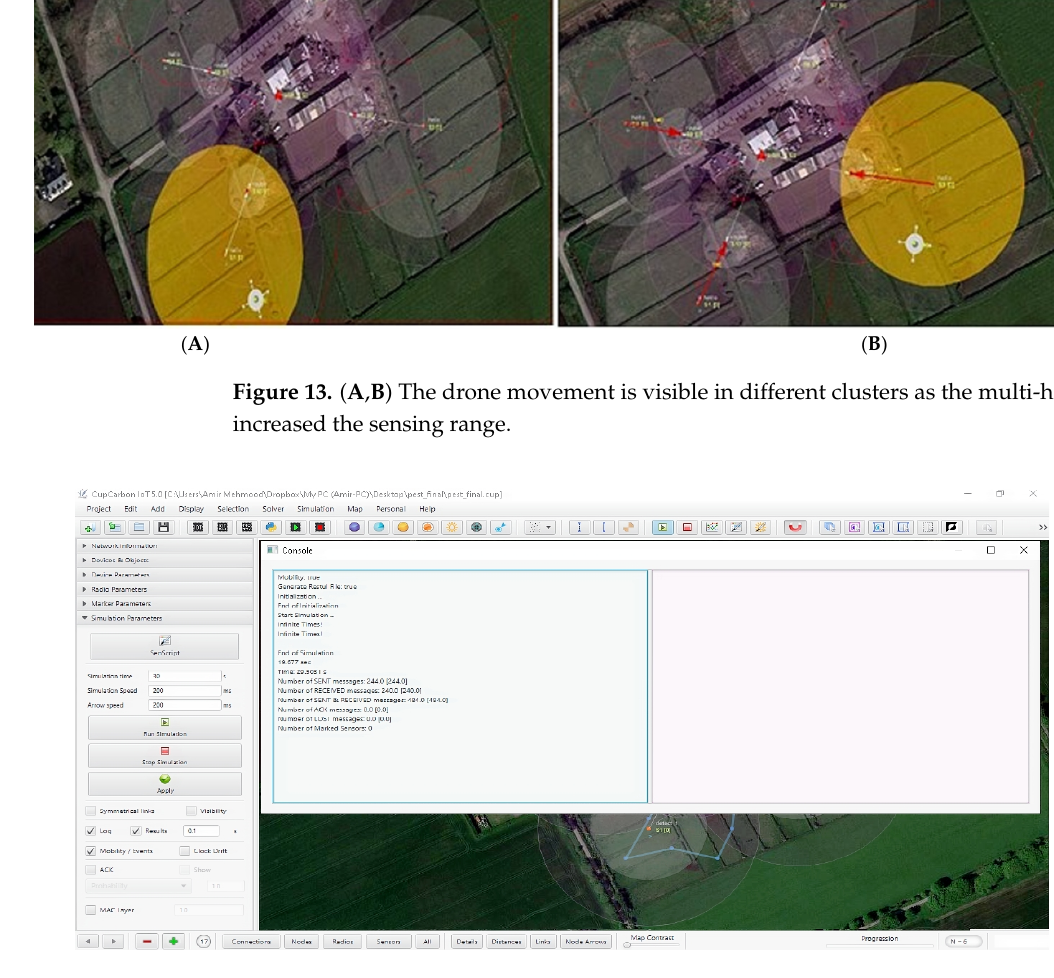
Figure 14. Console of Cup-Carbon simulator presents the results of the simulation.